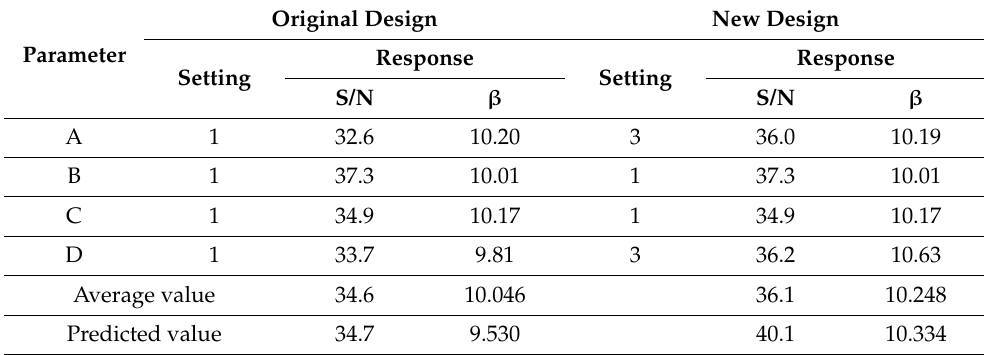
Table 2. Predicted values of S/N ratio and β for the original factory and new